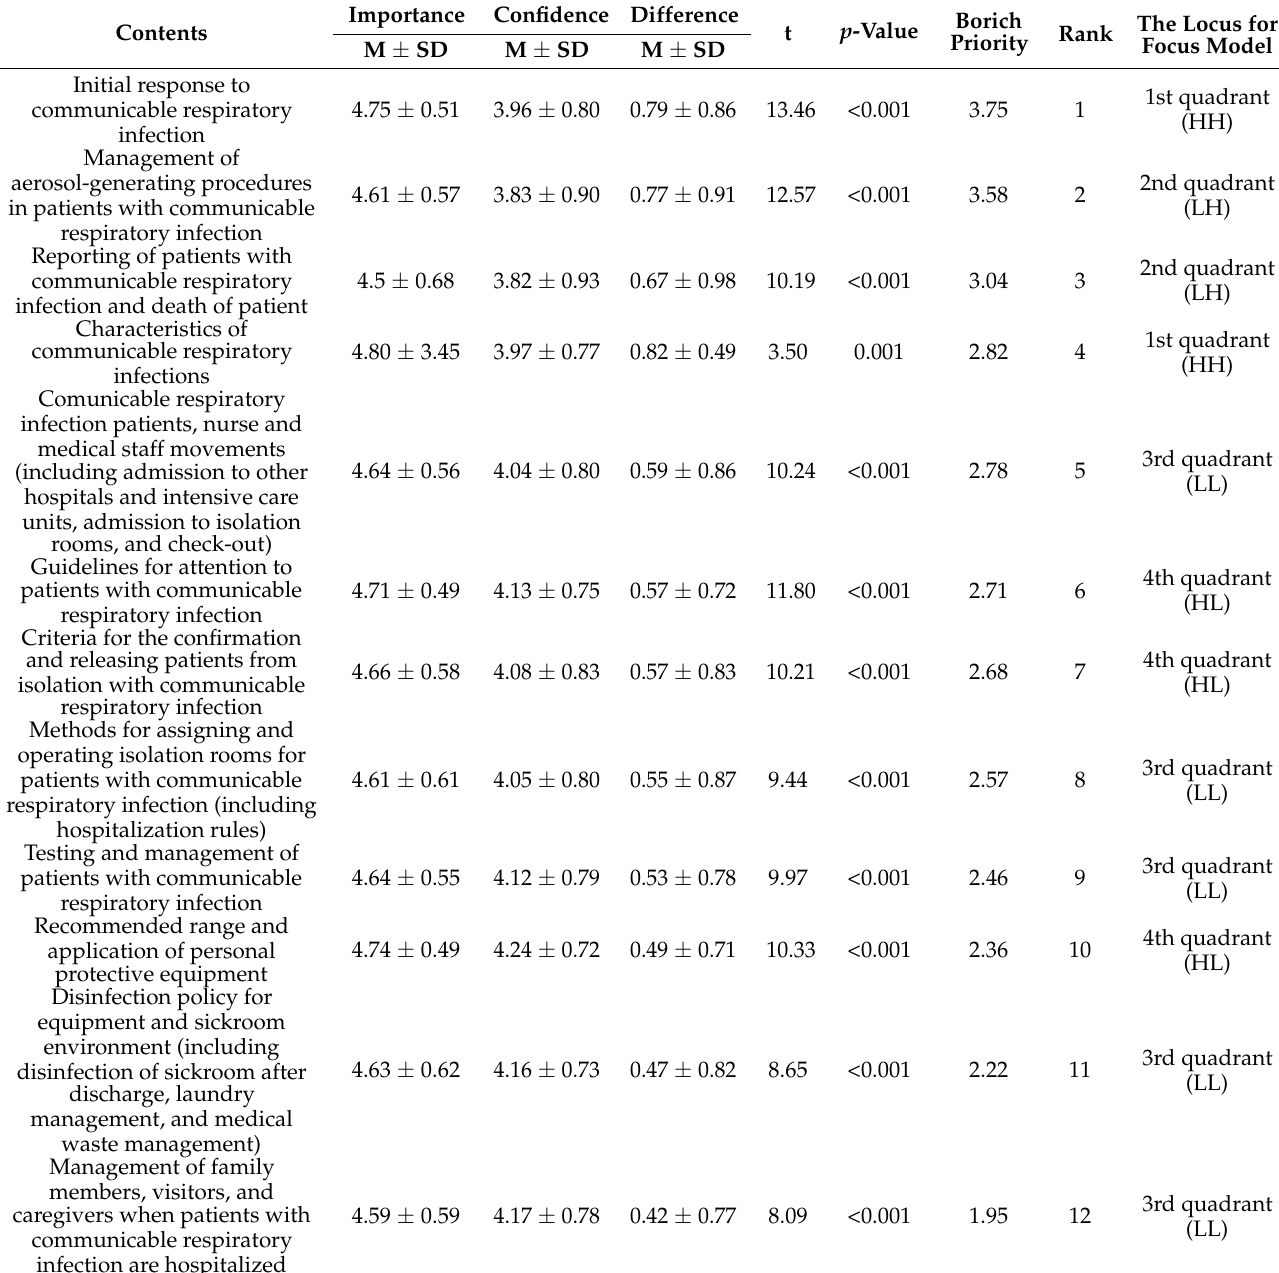
Table 2. Analysis of educational needs and priority of education among participants with prior experience in COVID-19 patient